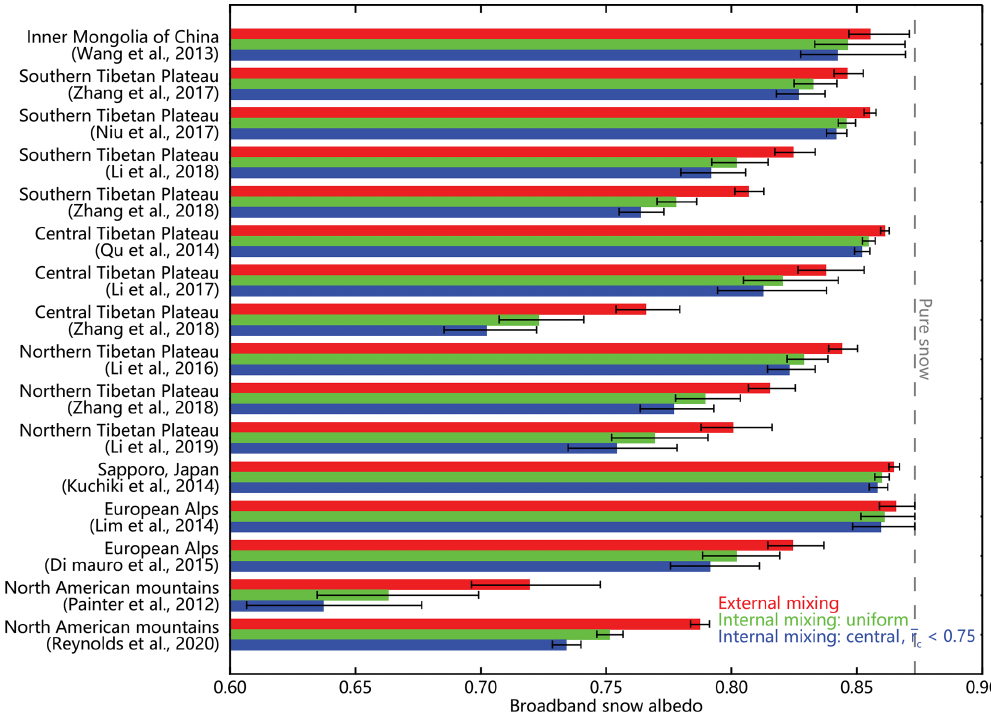
Figure 10. Calculated broadband snow albedo based on dust concentration measurements in different areas for dust–snow external mixing, internal mixing (uniform), and internal mixing (central, r c < 0 . 75). The dashed line represents broadband albedo of pure snow, and the snow grain radius was assumed to be